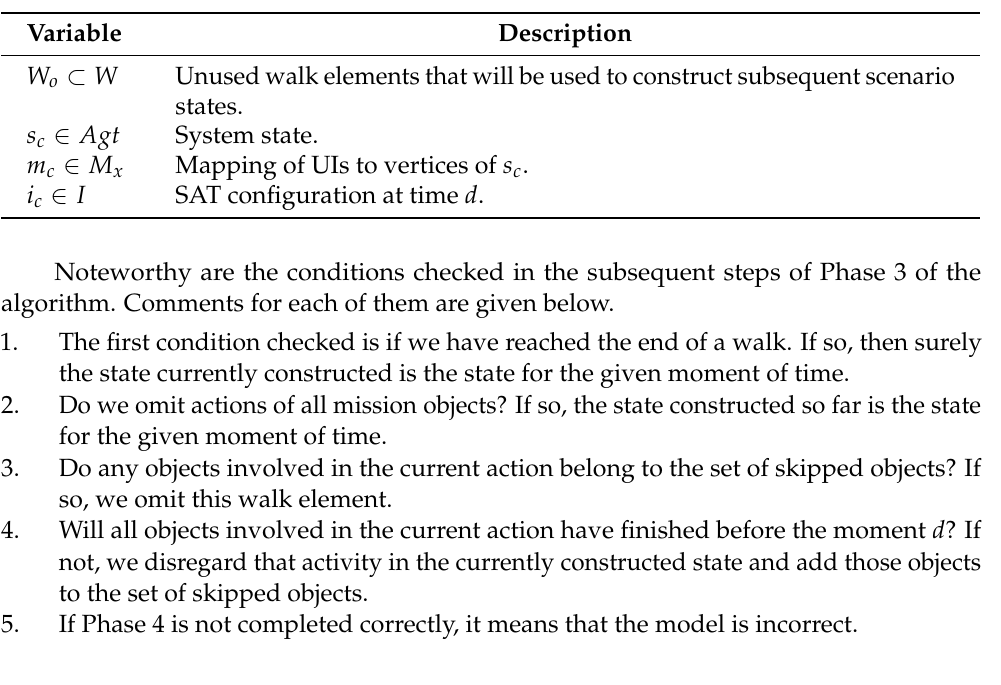
Table 9. Output data of Phase 3